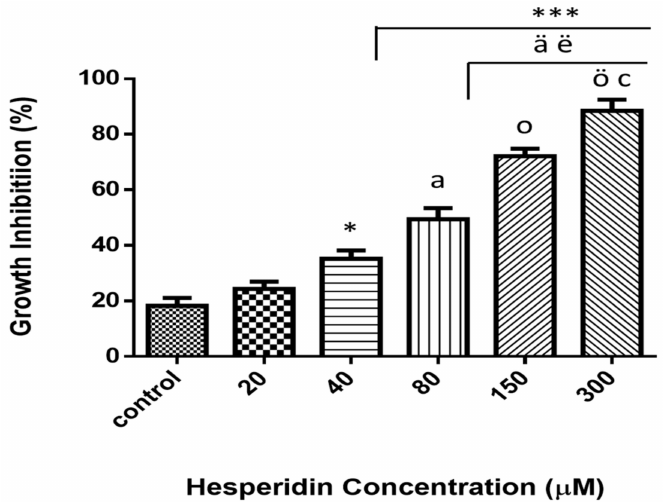
Figure 2. Cytotoxicity e ff ect of various concentrations (0–300 µ M) of hesperidin on MCF-7 breast cancer cell lines. Dose-dependent cytotoxicity e ff ect of hesperidin was presented. Cells did not reveal significant cytotoxicity with lower dose at 24 h of exposure. * Significant di ff erences versus control at p < 0.05, ***at p < 0.001. a Significant di ff erences versus 20 µ M at p < 0.01, ä at p < 0.001. ë Significant di ff erences versus 40 µ M at p < 0.01. o significant di ff erences versus 80 µ M at p < 0.01, ö at p < 0.001. c Significant di ff erences between 150 NS 300 µ M at p < 0.05. Data represent mean ± SD of three independent experiments, each comprising duplicate